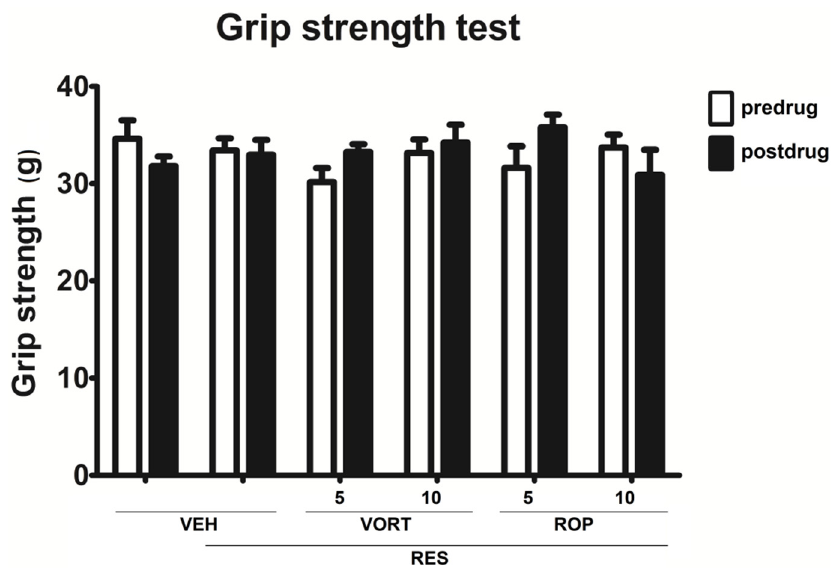
Figure 4. Anxiolytic-like properties of intraperitoneally administered vortioxetine (VORT; 5 and 10 mg/kg) and ropinirole (ROP; 5 and 10 mg/kg) in the mouse FM-like model induced by a 3-day administration of subcutaneous reserpine (RES; 0.25 mg/kg). The effect of test drugs on the num- ber of punished crossings was measured in the FPT performed 1 h after drug administration. Re- sults are shown as the mean number of punished crossings ± SEM for n = 8–10. Statistical analysis: one-way analysis of variance, followed by Dunnett’s post hoc test. Significance vs. RES + VEH group: * p < 0.05, ** p < 0.01, and **** p < 0.0001.